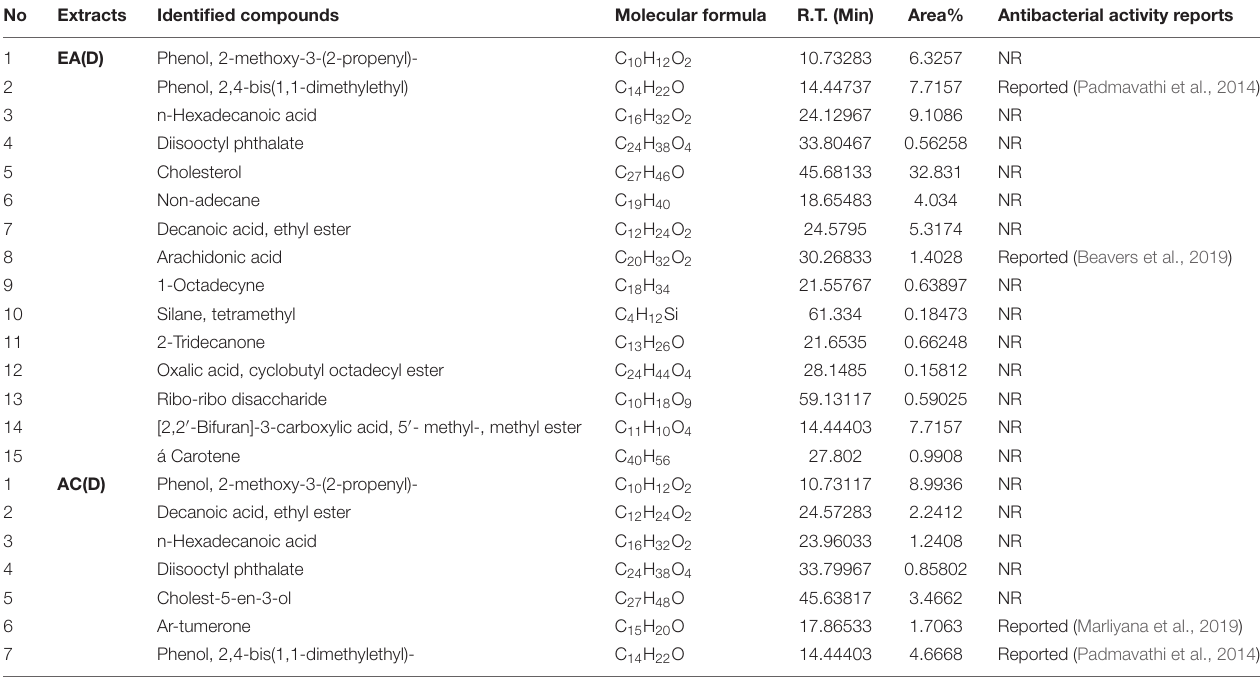
TABLE 4 | Compounds existing in G. edulis ethyl acetate and acetone (D) extracts identified by GC-MS